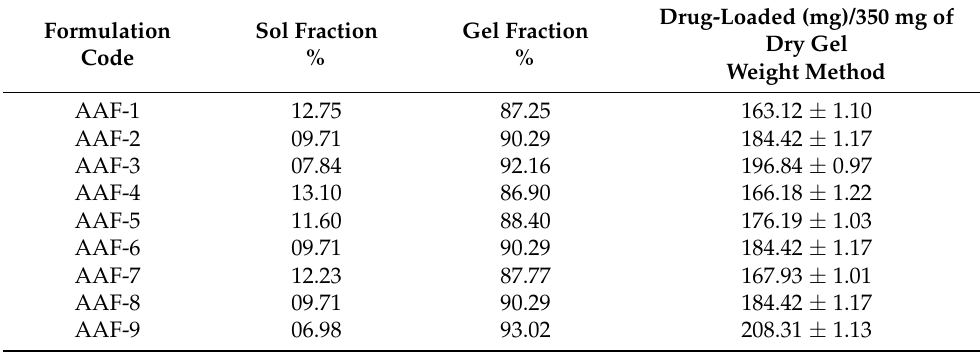
Table 1. Sol − gel analysis and drug loading of ASP/ALPAA hydrogels.